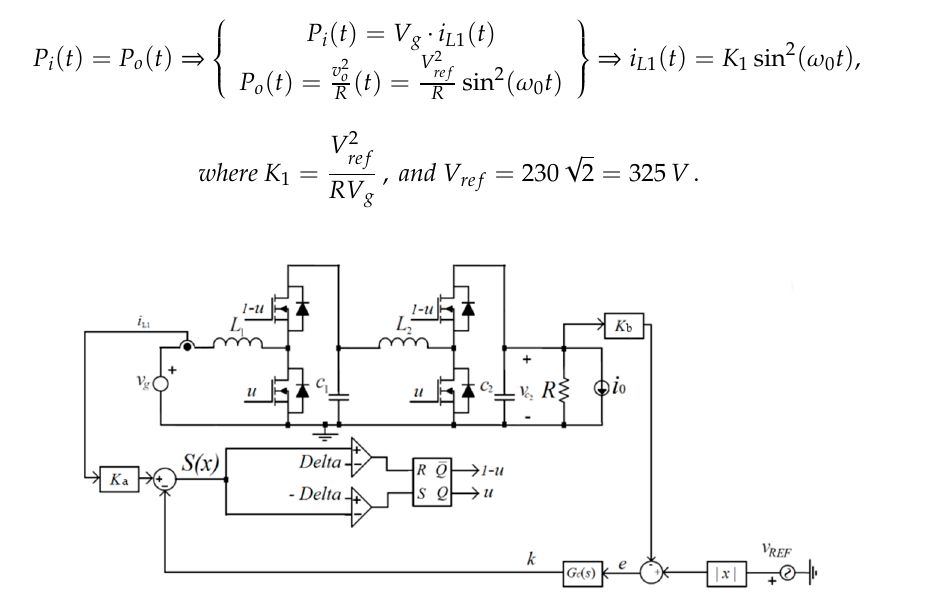
Figure 8. Input current control strategy.